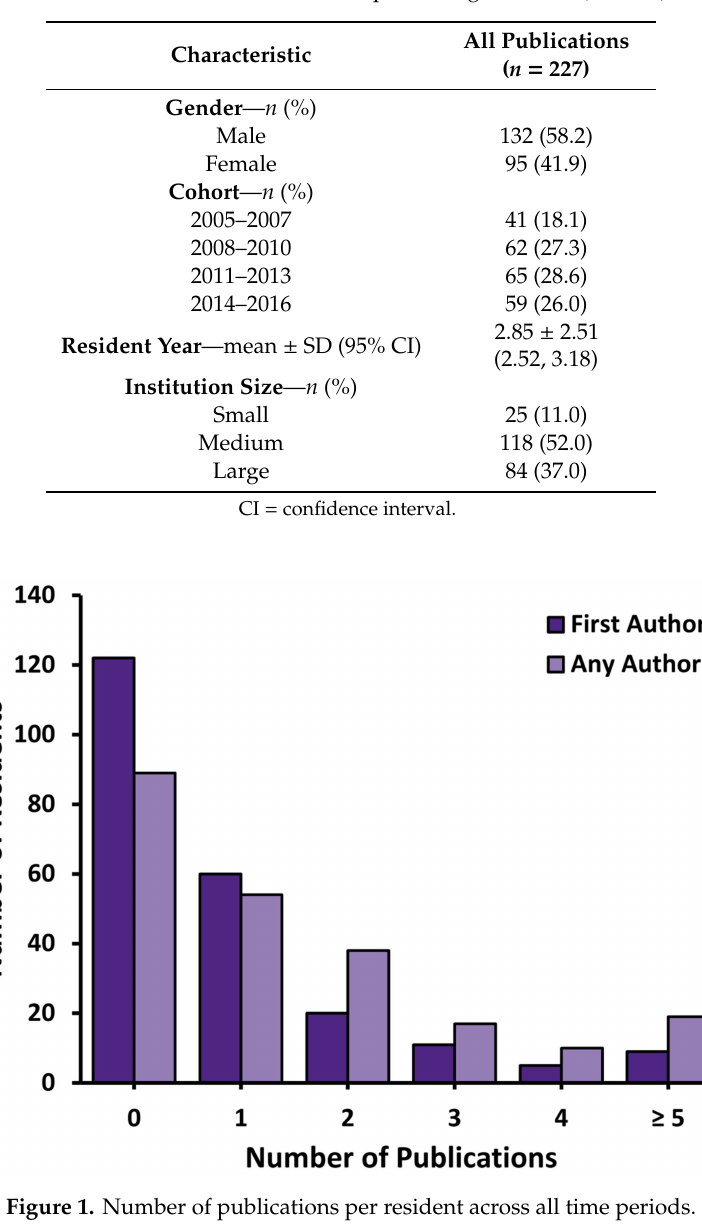
Table 1. Baseline characteristics of publishing residents ( n = 227).